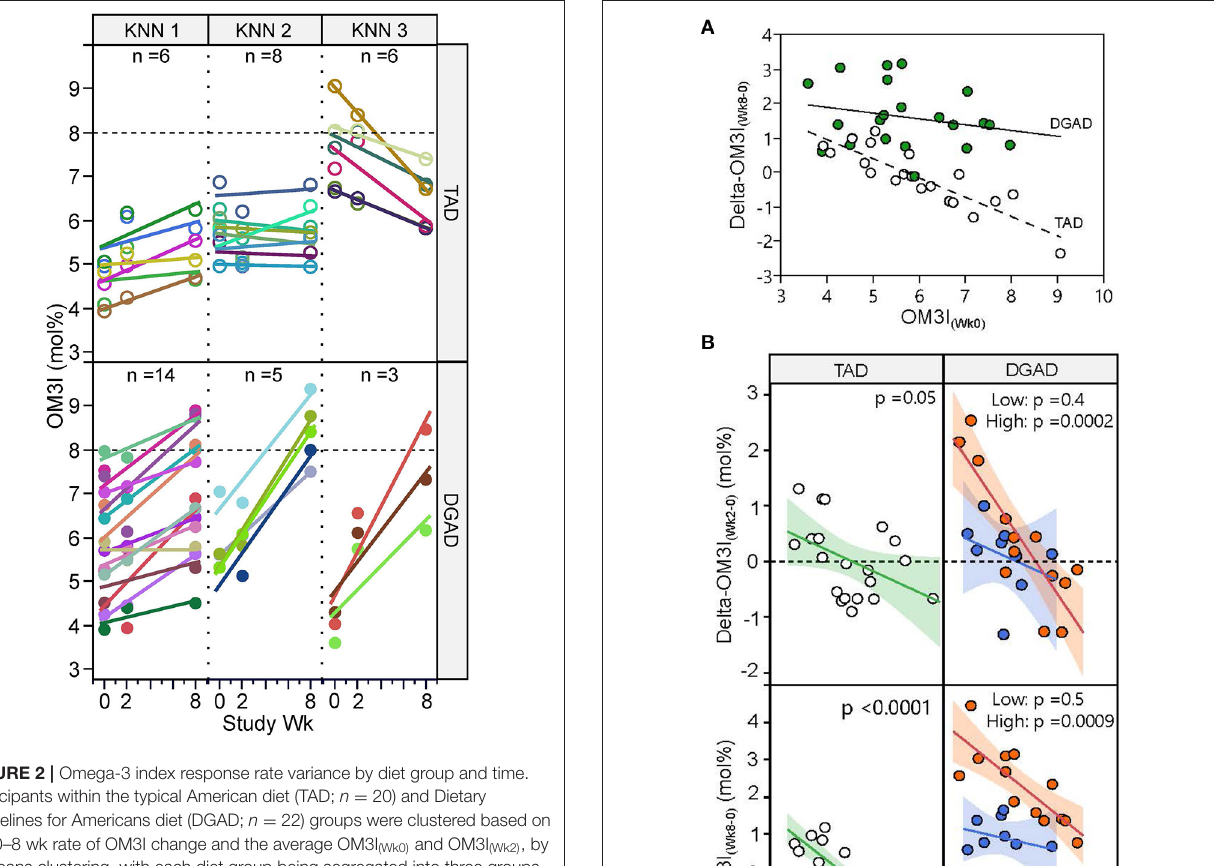
and Wk0 body composition ( Supplementary Table 3 ) were explored for factors associated with the OM3I (Wk0) using all subjects with complete baseline data ( n = 43). As seen in Figure 5 , the OM3I (Wk0) , habitual omega-3 fatty acid intake and body composition variables condense into four correlated variable clusters. The OM3I (Wk0) showed strong negative correlations with the android fat mass, android:gynoid